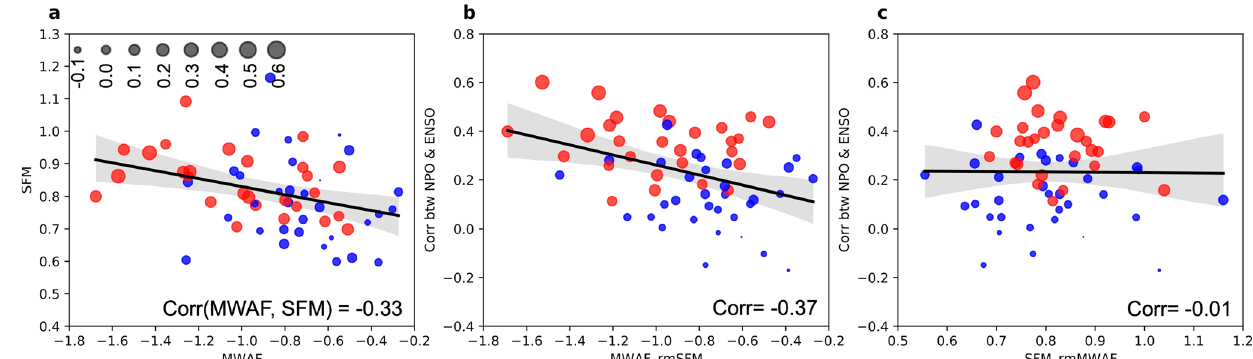
Fig. 12 Scatter diagrams showing the relative importance of MWAF and SFM. a The scatter plot of MWAF and SFM with and correlation coef fi cients between D0JFM1-averaged NPO and following winter ENSO for each model marked as different sizes of dots. b The scatter plot of MWAF without SFM signal (linearly removed) and correlation coef fi cients between NPO and ENSO. c The scatter plot of SFM without the MWAF signal (linearly removed) and correlation coef fi cients between NPO and ENSO. Here, the correlations between the two-dimensional variables are shown in each subplot and the red (blue) dots represent the ENSO magnitude above (below) the average of 59